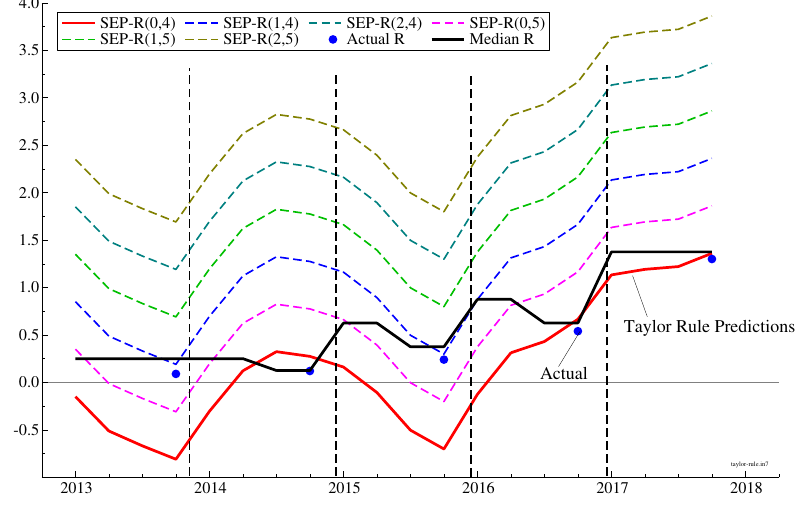
Figure 4. Interest-Rate Predictions—Sensitivity to Values of the Natural